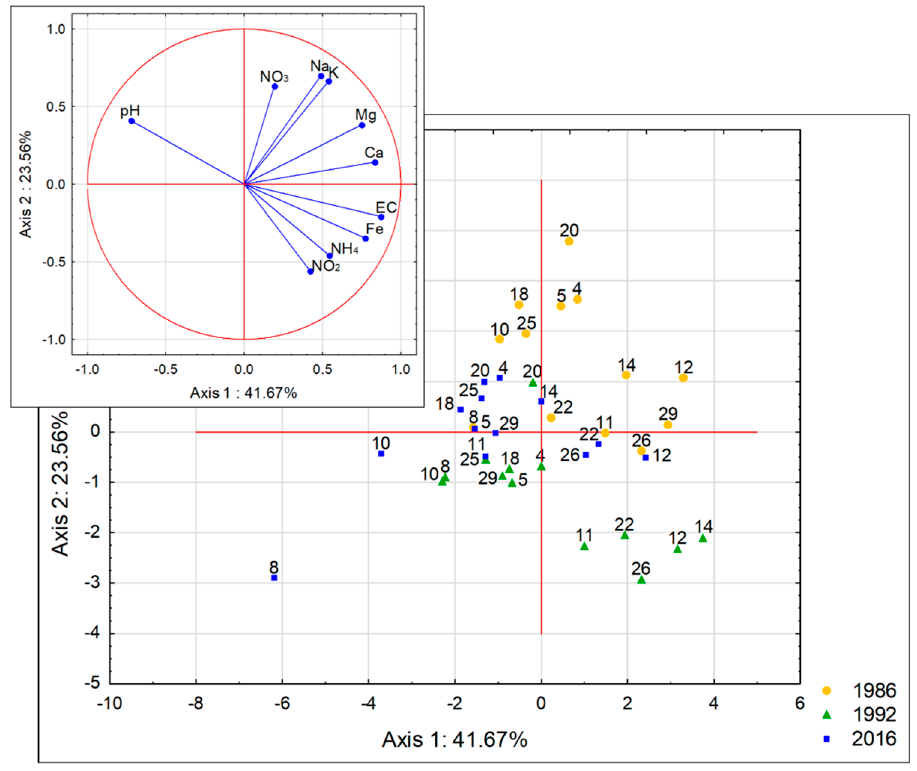
Figure 3. Principal Components Analysis (PCA) for the lakes studied in the Muskau Arch— differentiation across the selected hydrochemical characteristics (preceded by factor analysis). The distinguished groups (colored) indicate the years of study. Explanations: NO 3 —nitrate nitrogen, NH 4 -